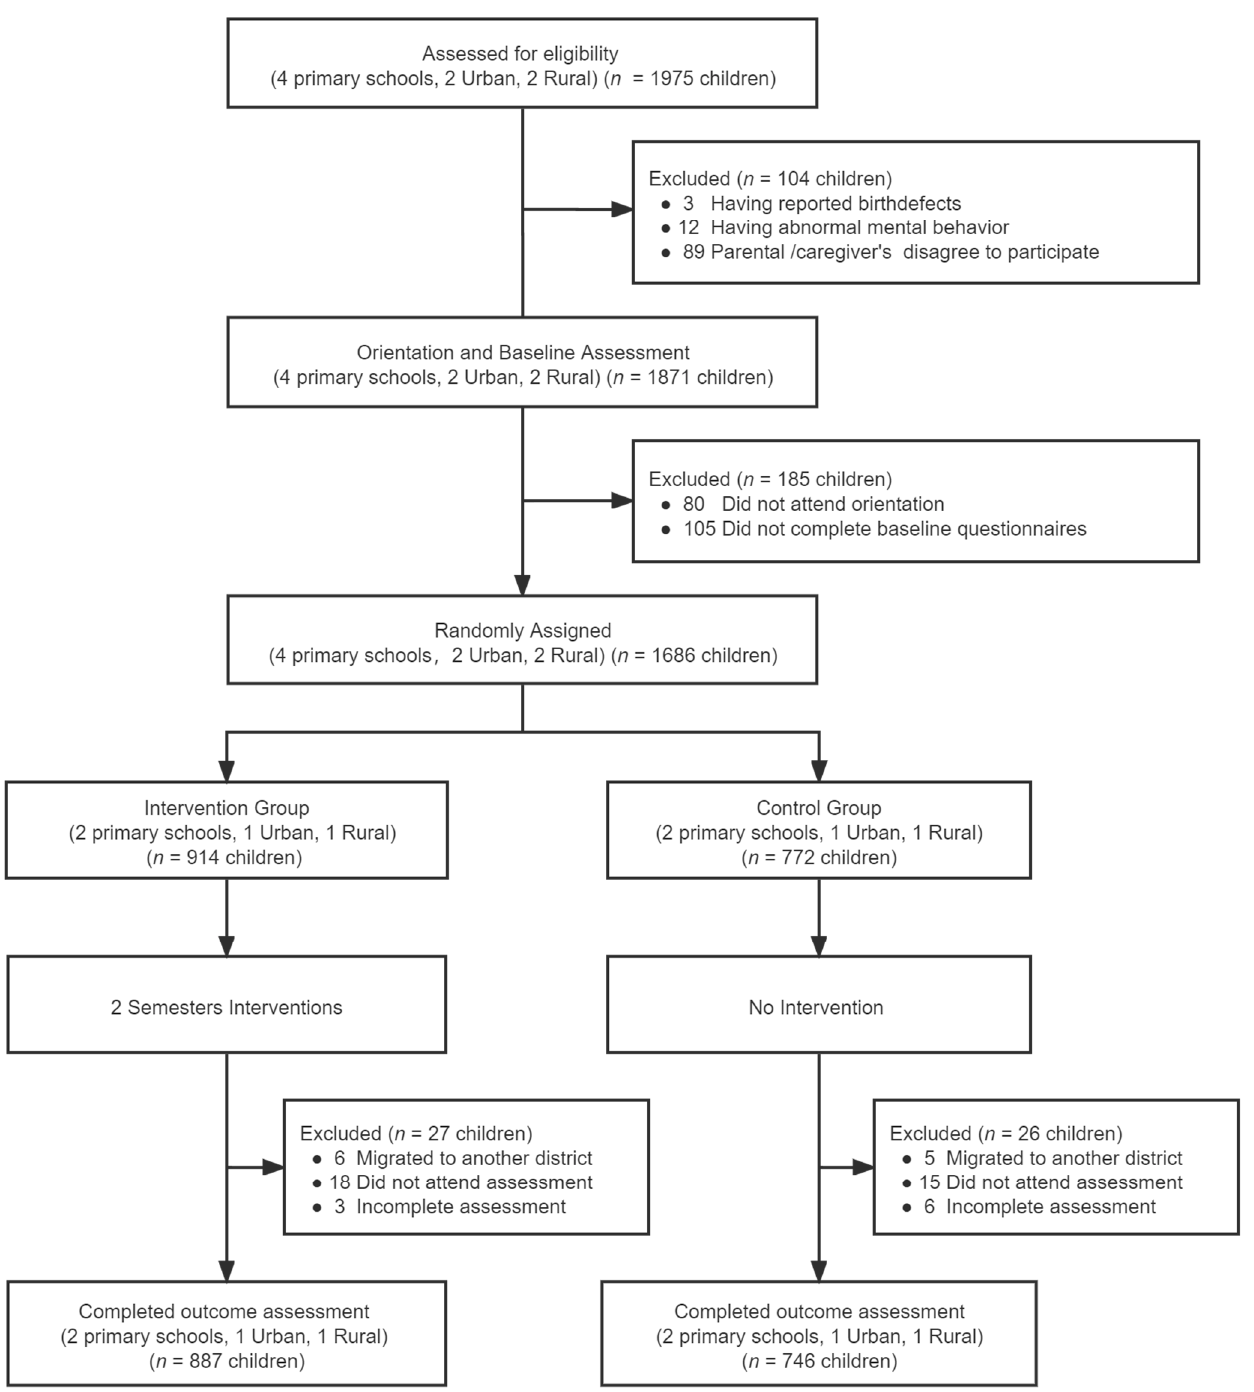
Figure 1. Flow of Figure 1. Flow of participation. Table 1. Demographic characteristics between subjects retained in trial and dropped out (N/%, Mean ± SD ).